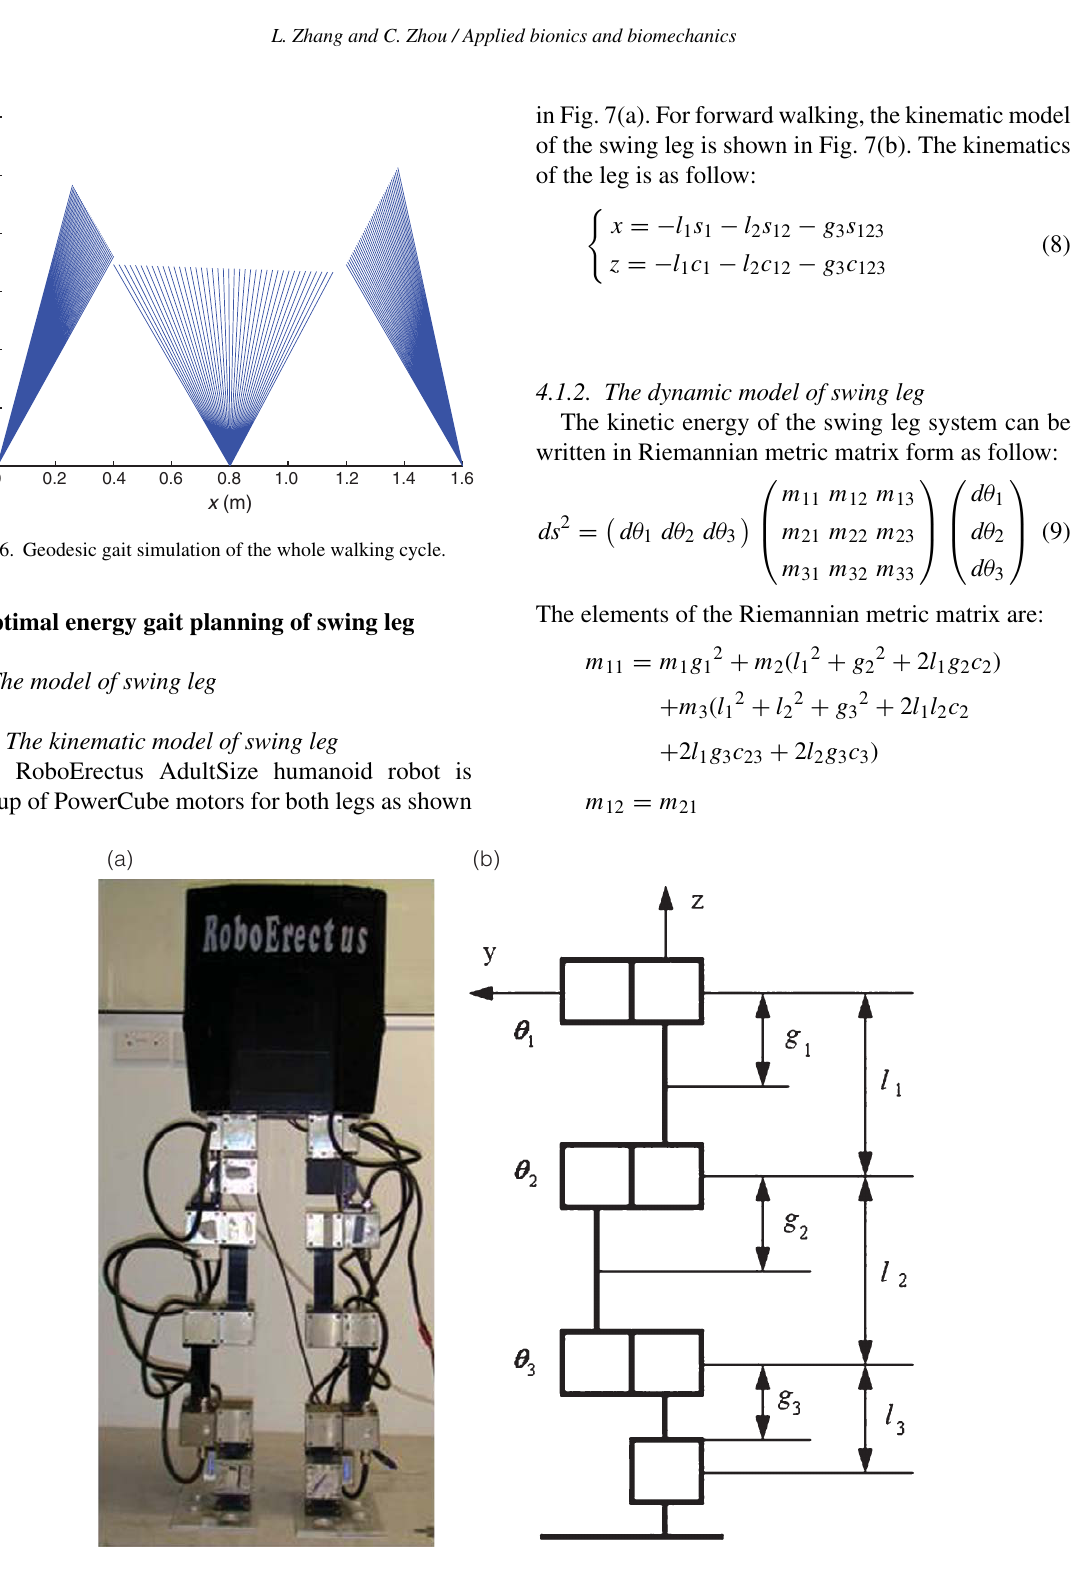
Fig. 7. (a) RoboErectus AdultSize robot (b) model of swing